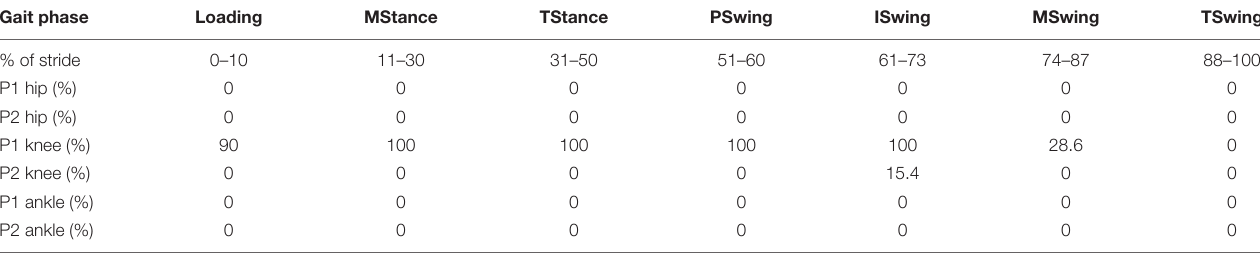
TABLE 4 | The results of SPM left vs. right leg analyses separated by gait cycle phases for each participant. Gait phase